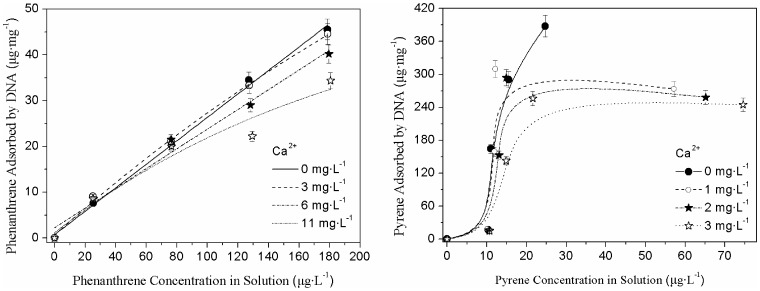
The influence of Ca2+ on phenanthrene (left) and pyrene (right) adsorption by DNA.The concentration of sorbent (DNA) in solution was 11.73 mg·L–1. Error bars represent 1 standard deviation (n = 3).